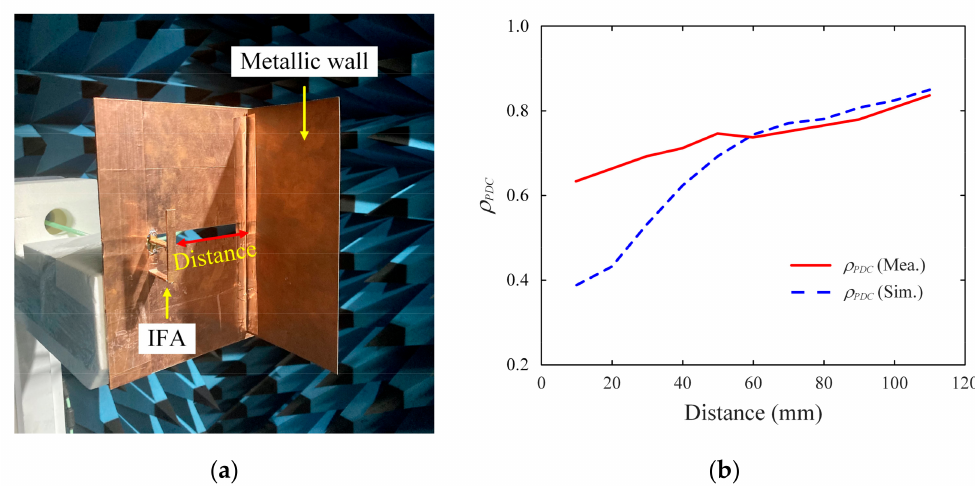
Figure 12. Photograph of the measurement set-up and measured results. ( a ) Measurement of ρ PDC for the fabricated IFA in an anechoic chamber. ( b ) Simulated and measured ρ PDC according to distance.